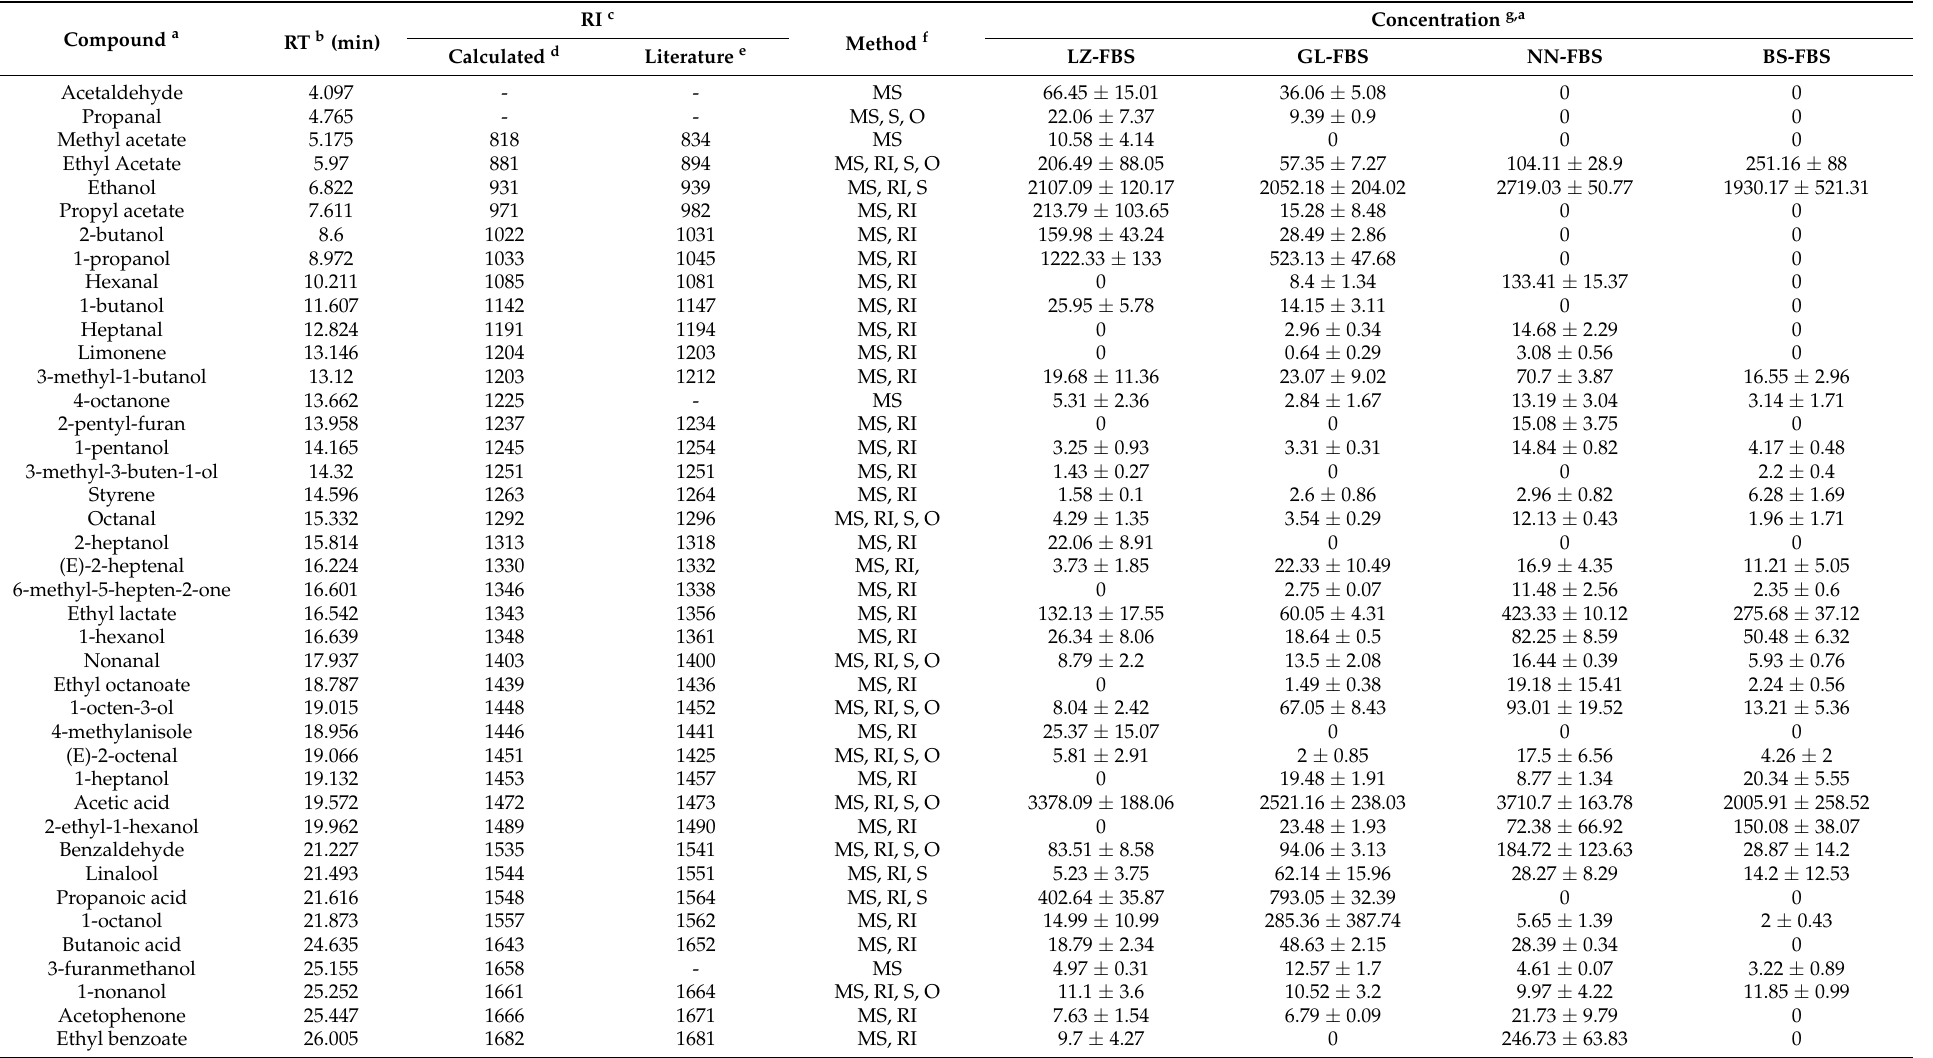
Table 1. Volatile compounds identified and quantitated in FBS by